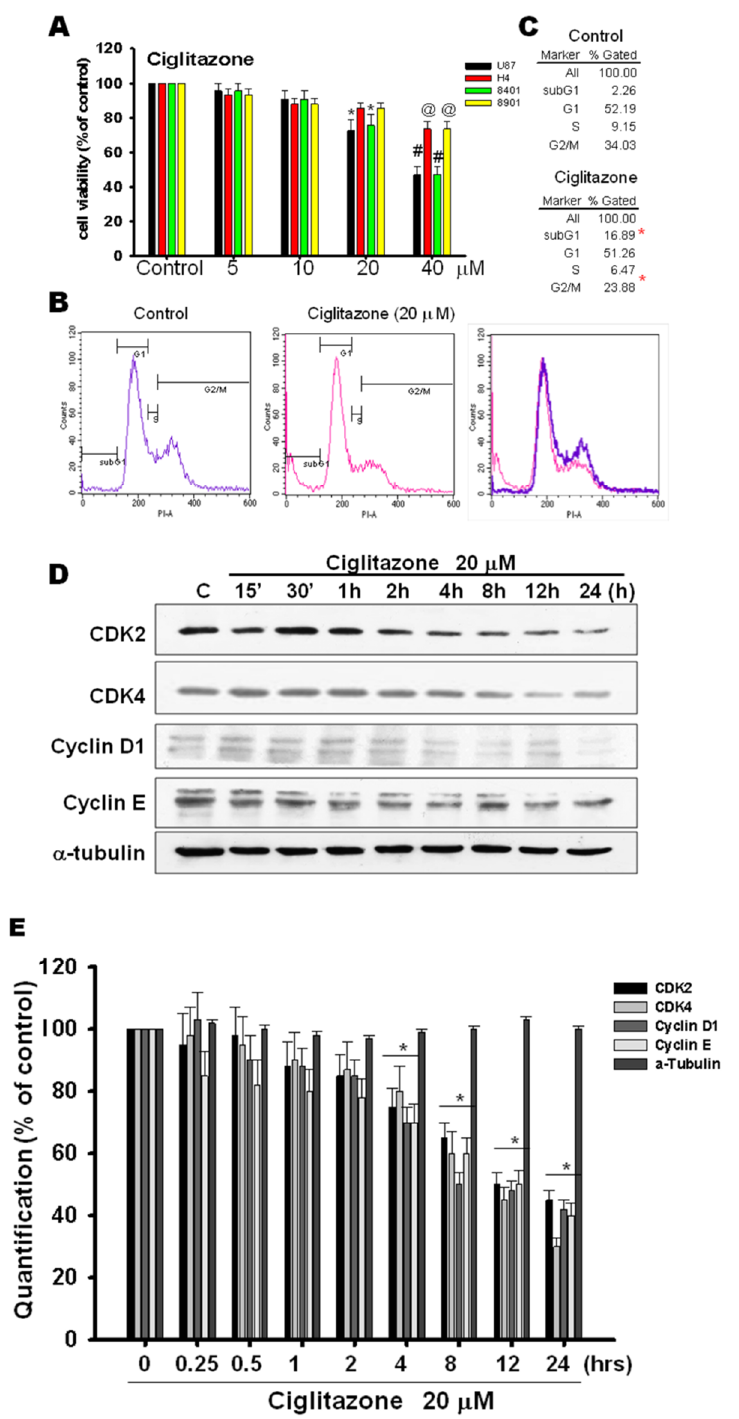
Figure 6. The influence of cell cycle associated proteins by ciglitazone. U87 were treated with ciglitazone in a dose-escalated course and analyzed by MTT and flow cytometry assay and also determined in cell-cycle-associated proteins. ( A ) Four glioma tumor cell lines, U87 (black), H4 (red), 8401 (green), and 8901 (yellow) were analyzed under dose-dependent (0, 5,10, 20, and 40 μM) using MTT assay at 24 h. ( B ) Cell cycle histogram showed phase distribution (subG0, G1, S, and G2/M) of cells at 24 h post-ciglitazone-induction in U87 cells. The plot showed the increase pro- portion in SubG0 phase but decrease in G2/M phase after ciglitazone treatment. ( C ) Upper panel for control in cell phase distribution, and lower panel for ciglitazone treatment in cell phase dis- tribution. ( D ) Ciglitazone (20 μM) induced cell cycle arrest by Western blot analysis. Western blot